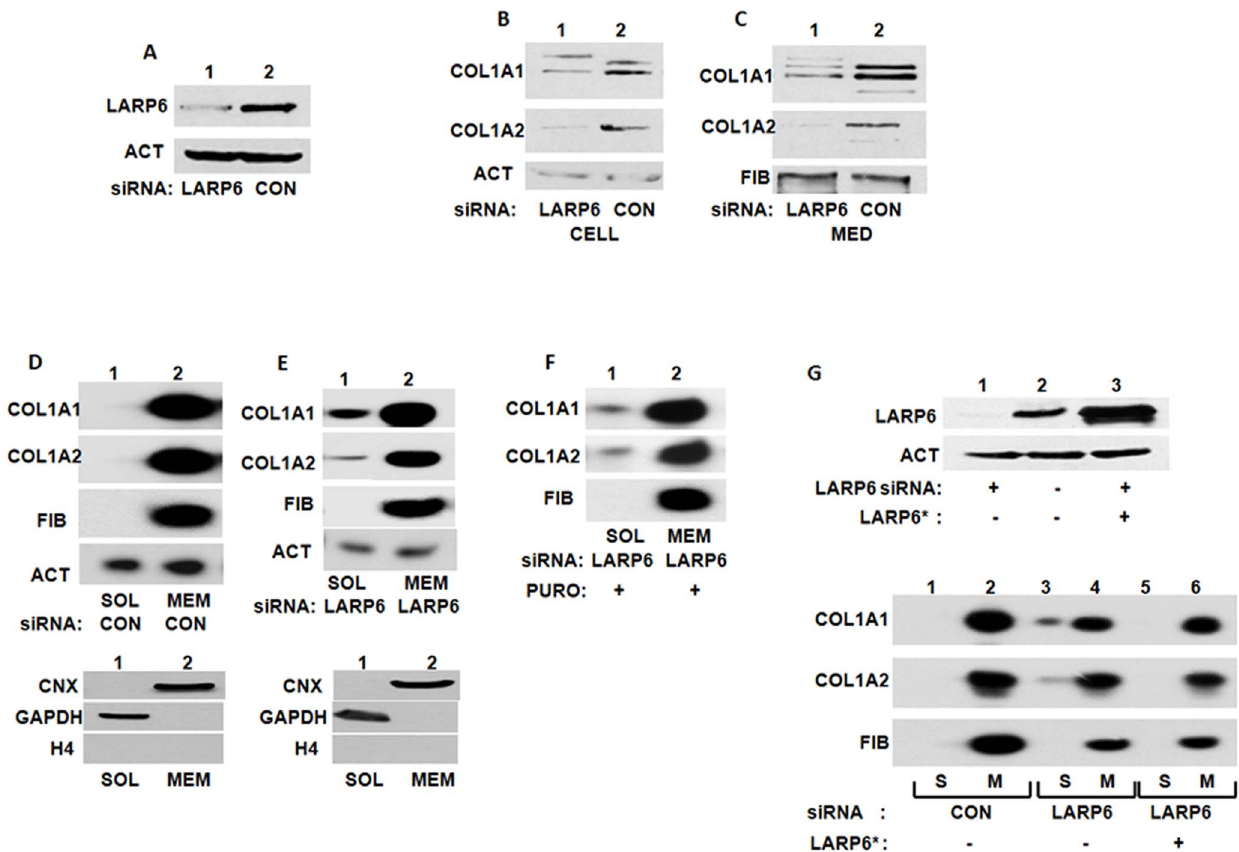
Figure 2. Knock down of LARP6 decreases expression of type I collagen. A. Knock down of LARP6. Expression of LARP6 was analyzed by western blot in HLFs after transfection of LARP6 siRNA (lane 1) and control siRNA (lane 2). Loading control: actin (ACT). B. Cellular level of collagen polypeptides after LARP6 knock down. Collagen a 1(I) (COL1A1) and a 2(I) (COL1A2) polypeptides were analyzed by western blot in LARP6 knock down HLFs (lane 1) and control HLFs (lane 2). C. Secretion of collagen polypeptides into the cellular medium. Cellular medium of cells in B was analyzed by western blot. Loading control: fibronectin (FIB). D. Partitioning of collagen mRNAs in control cells. Upper panel: HLFs transfected with control siRNA were fractionated into cytosolic (SOL) or membrane (MEM) fraction and analyzed for presence of collagen mRNAs and actin (ACT) and fibronectin (FIB) mRNAs by RT-PCR. Bottom panel: distribution of the marker proteins. E. Partitioning of collagen mRNAs in LARP6 knock down cells. Experiment as in D, except LARP6 siRNA was transfected. F. Partitioning of collagen mRNAs in LARP6 knock down cells after puromycin treatment. Experiment as in E, except the cells were treated with puromycin for 3 h. G. Rescue of partitioning of collagen mRNAs by supplementing LARP6. Upper panel: expression of LARP6 in LARP6 knock down cells (lane 1), in control cells (lane 2) and in LARP6 knocked down cells transduced with LARP6 adenovirus (lane 3). Loading control: actin (ACT). Bottom panel: Distribution of collagen mRNAs in the soluble (S) and membrane (M) fractions of control cells (lanes 1 and 2), LARP6 knock down cells (lanes 3 and 4) and LARP6 knock down cells supplemented with exogenous LARP6 (lanes 5 and 6).